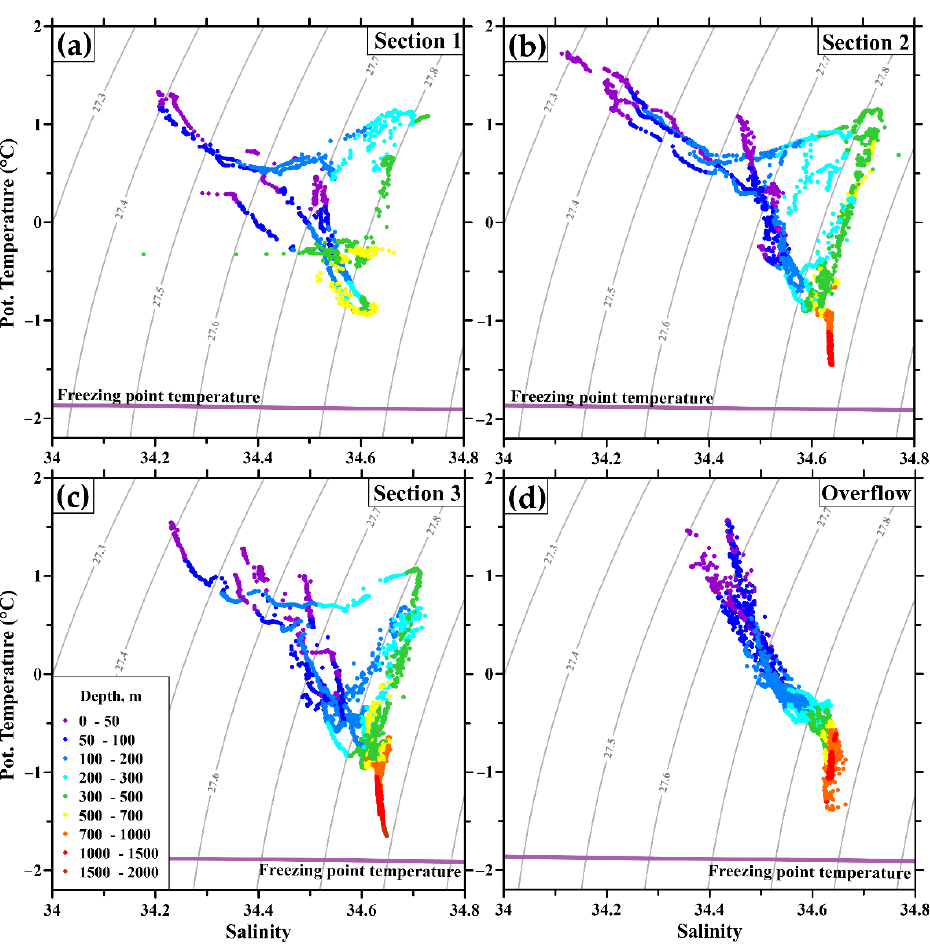
Figure 8. Temperature–salinity diagrams including the freezing-point temperature (magenta line) and sigma contours (gray lines) at the hydrographic stations at different sections in the BS. From west to east: ( a ) Section 1, ( b ) Section 2, ( c ) Section 3, ( d ) section across the deep overflow. The locations of the sections are shown in Figures 1 and 2. The colors of the dots indicate depths of measurements; see color scale in ( c ). The freezing-point temperature was calculated on the basis of EOS80 equations [44].